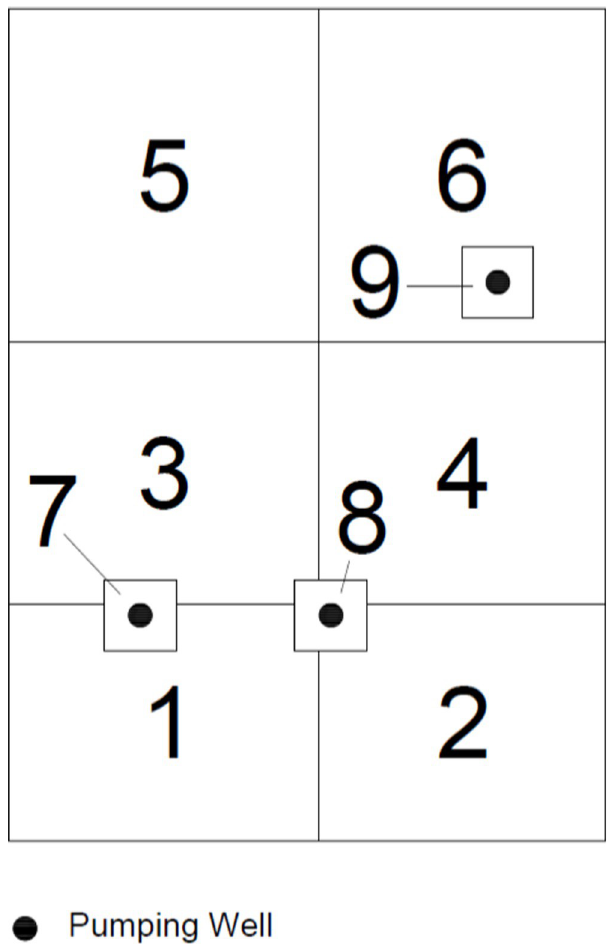
Fig 3. Small-scale test case experimental design